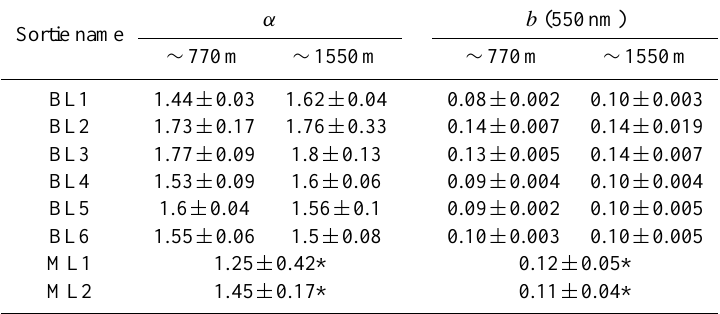
Table 3. Mean values of wavelength exponent ( α) and aerosol backscatter ratio ( b ) for all BL and ML sorties within and above MABL. * indicates columnar mean values.